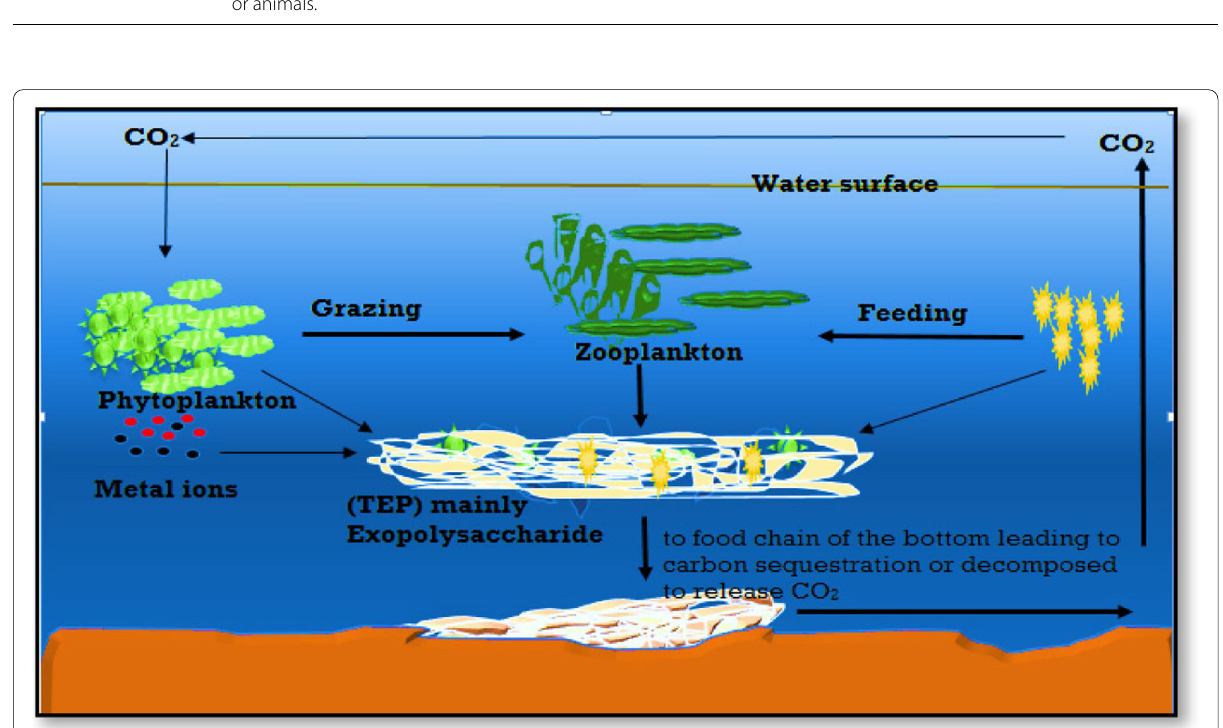
Fig. 7 Aggregation of organic carbon by exopolysaccharides and scavenge some metal ions then sink to the bottom